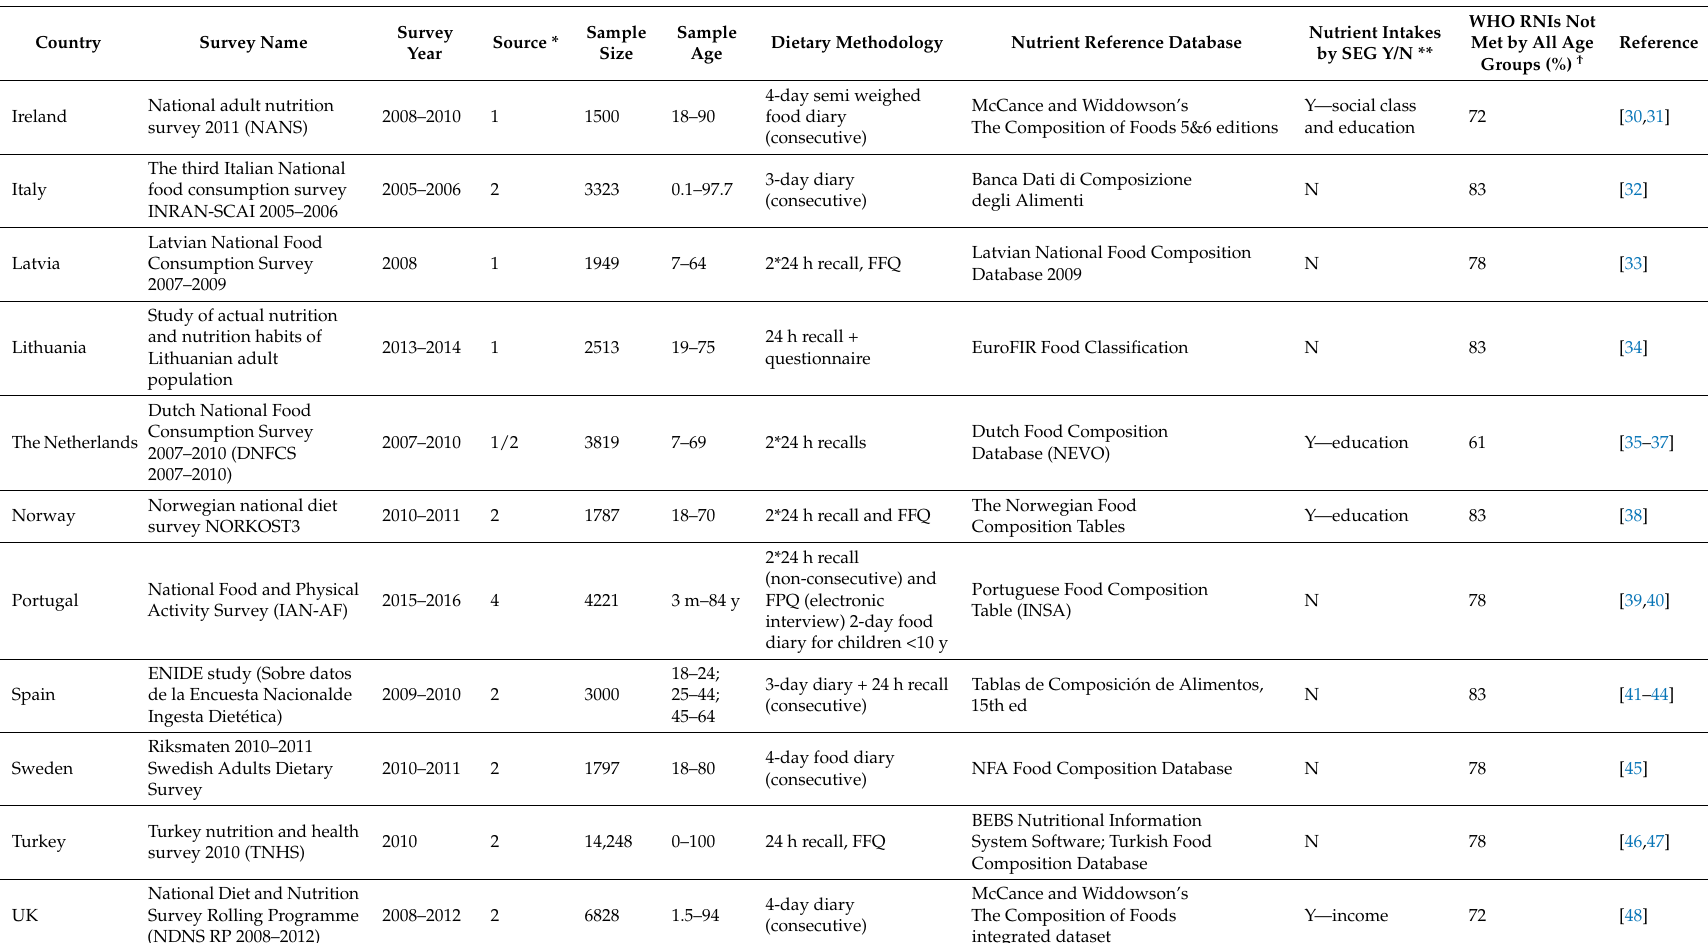
Table 3. National diet surveys across countries in WHO Europe 1990–2016 with nutrient intakes reported.